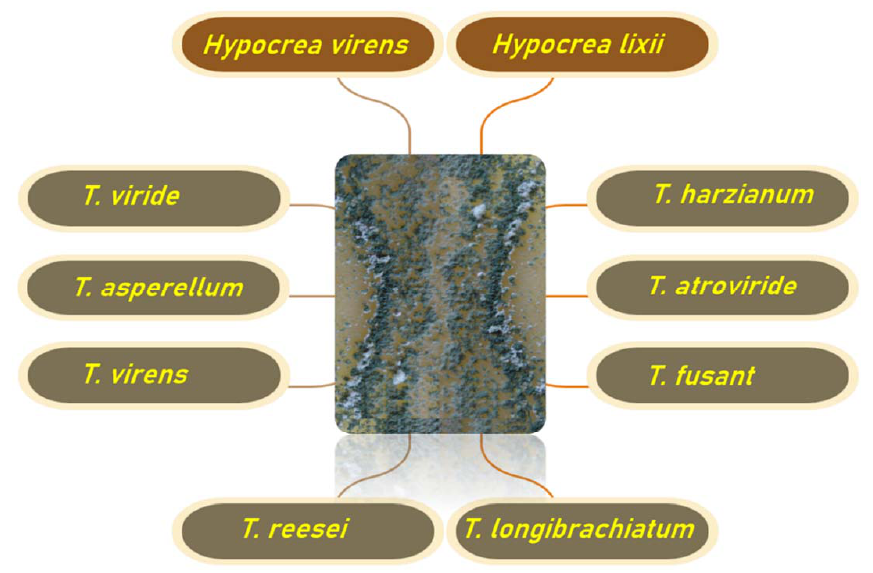
Figure 1. The top ten Trichoderma species used to produce safe metal nanoparticles through mycogenic synthesis.